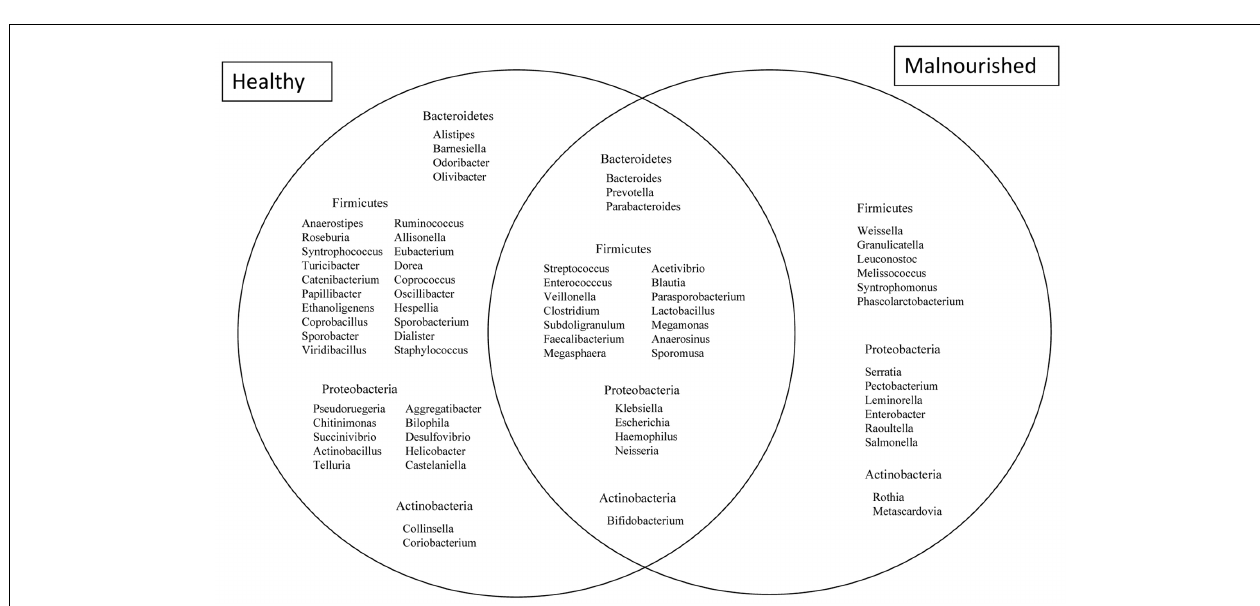
comparison. A total of 39 genera are characteristic of healthy children, 23 genera common between healthy and malnourished children and 14 genera are characteristic of malnourished